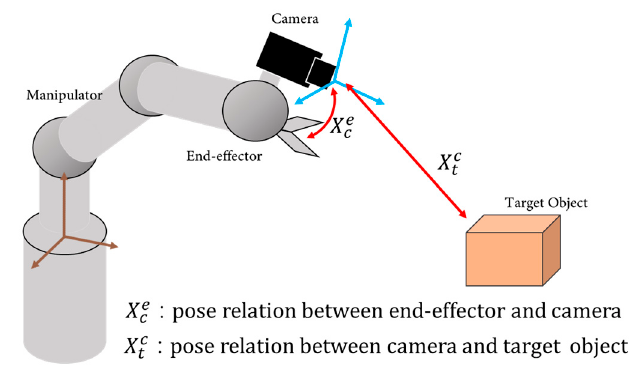
Figure 9. Eye-in-hand vison servo system.